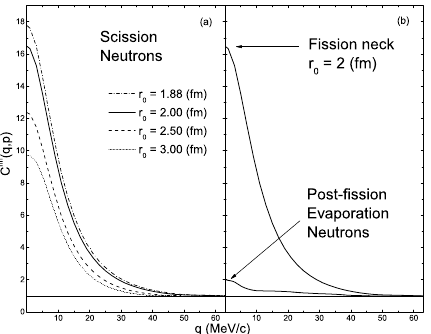
Fig. 1. C nn ( q ) for prompt fission neutrons as a function of relative momentum q (MeV / c). (a) C nn for scission neutrons for di ff erent values of r 0 . (b) Comparison between C nn for scission neutrons and C nn for neutrons emitted from fully accelerated